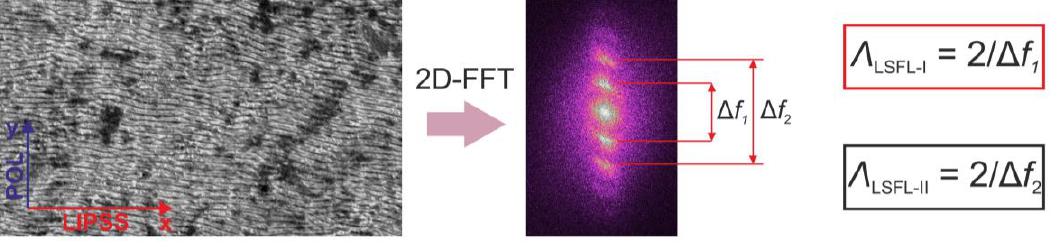
Figure 3. Graphical illustration of evaluation procedure of the LIPSS period. Arrows in the leftmost image show the directions of laser beam polarization (POL) and LIPSS grooves (LIPSS).